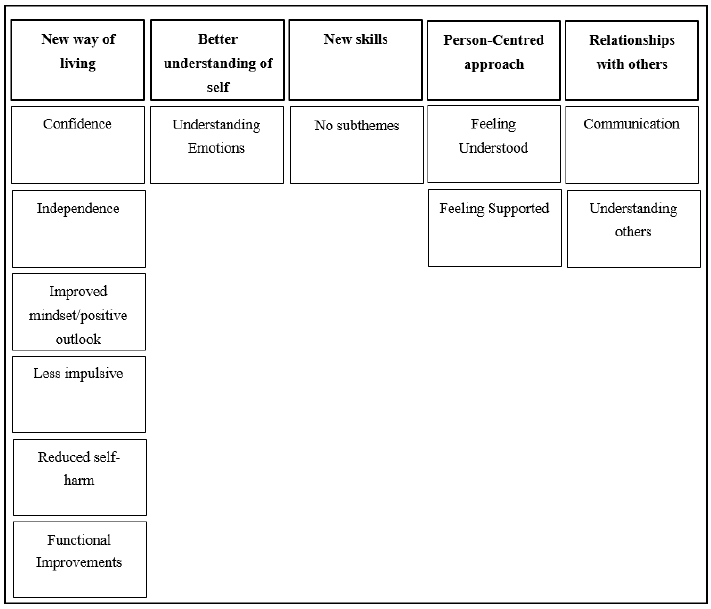
Figure 1. Thematic map representing young person themes and subthemes.